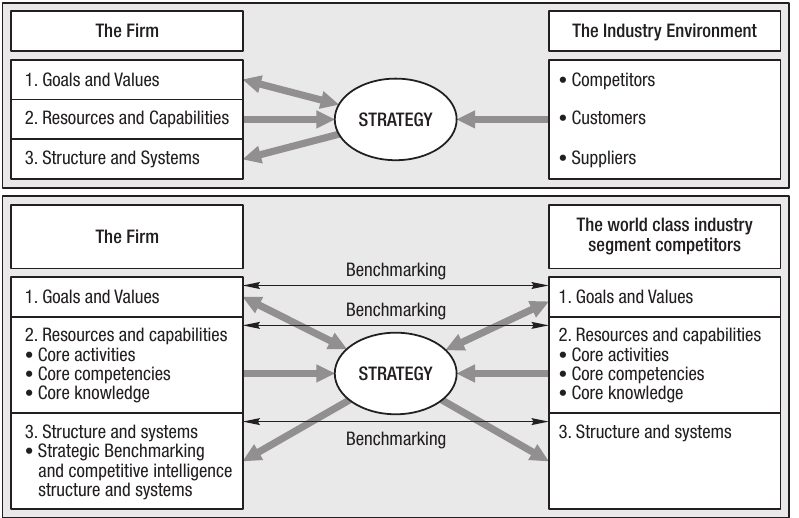
Fig. 9. Traditional SWOT analysis (top) & Extended SWOT analysis (down) (Marti 2004)